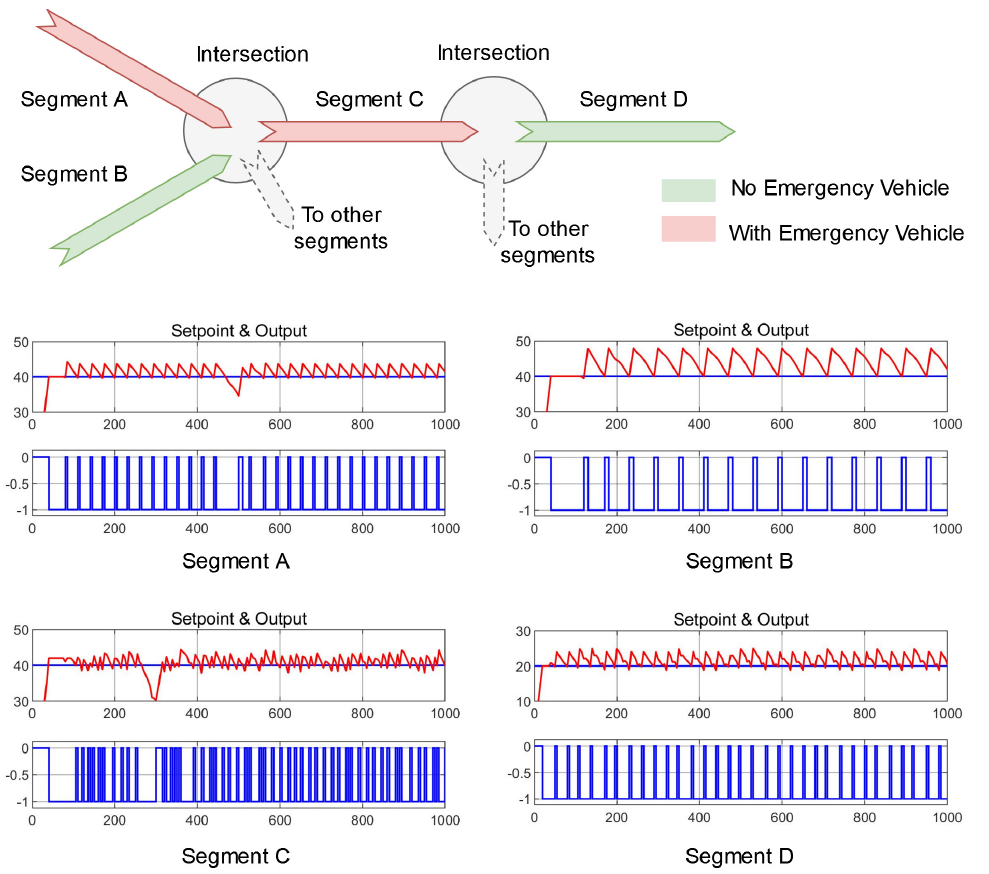
Figure 10. Single-lane road segments in a network, showing structure and time